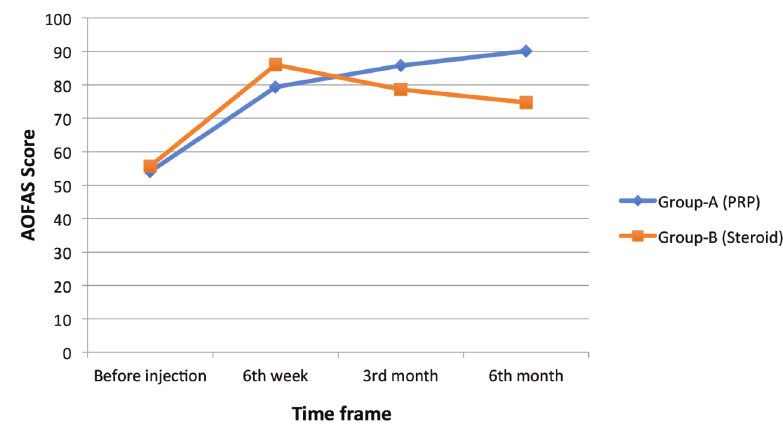
AOFAS before treatment and at different follow-up visits in both Fig. 2: